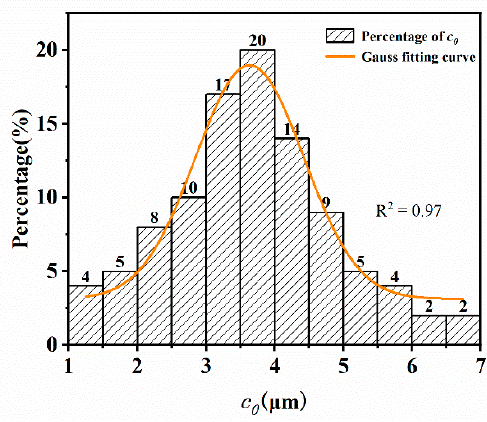
Figure 14. The representative SEM images of EPDM rubber composite surface in di ff erent area ( a ) and ( b ).